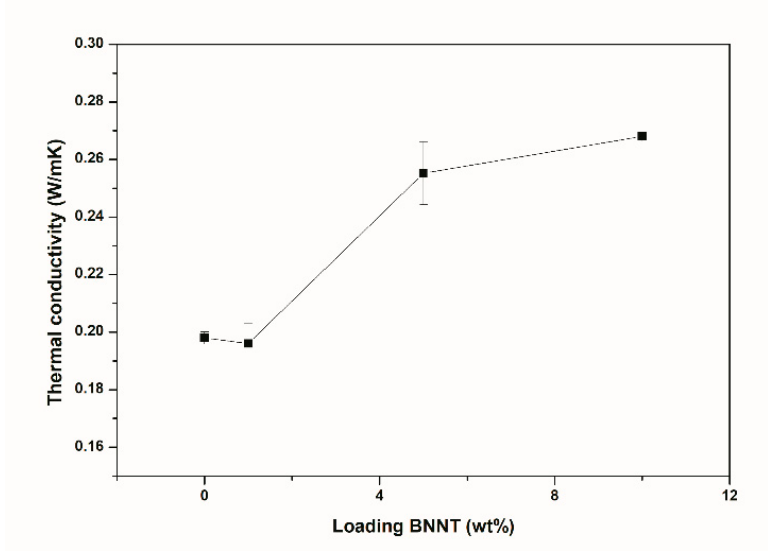
Figure 7. Thermal conductivity of the SBR/BNNTs nanocomposites.